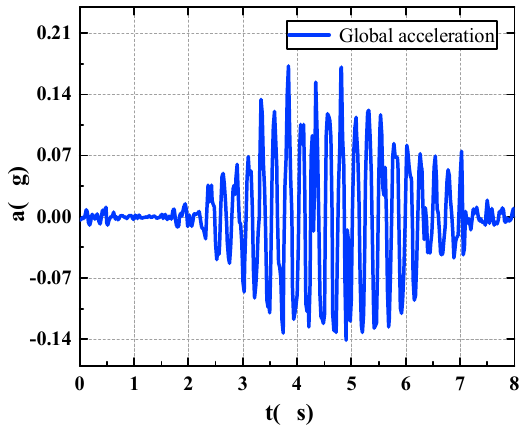
Figure 12. Global displacement of footbridge.